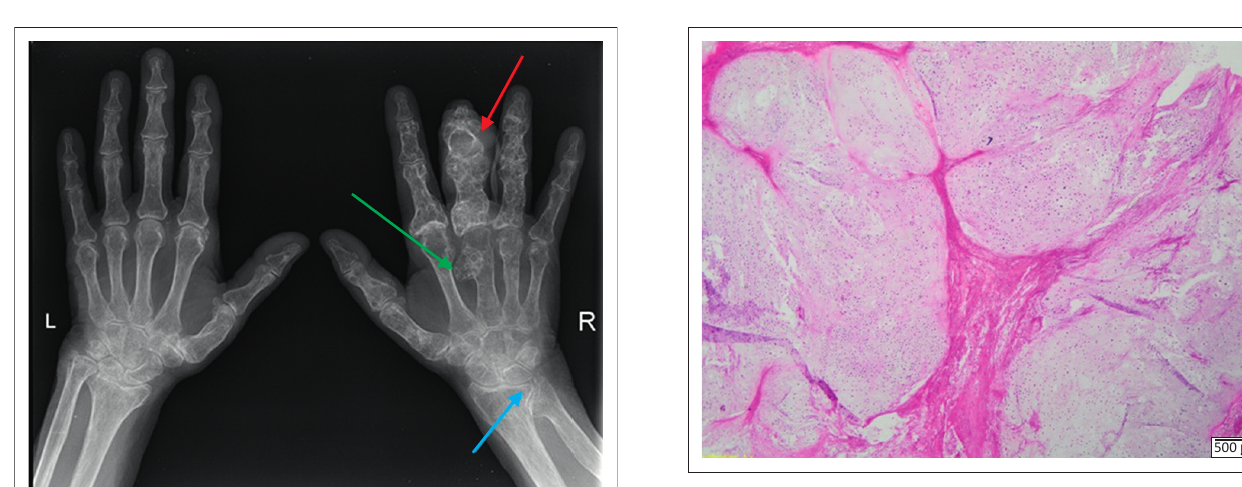
FIGURE 7: Haematoxylin and eosin staining, X 20 magnification. Lobulated hypercellular, cartilaginous neoplasm with a homogeneous basophilic hyaline matrix.